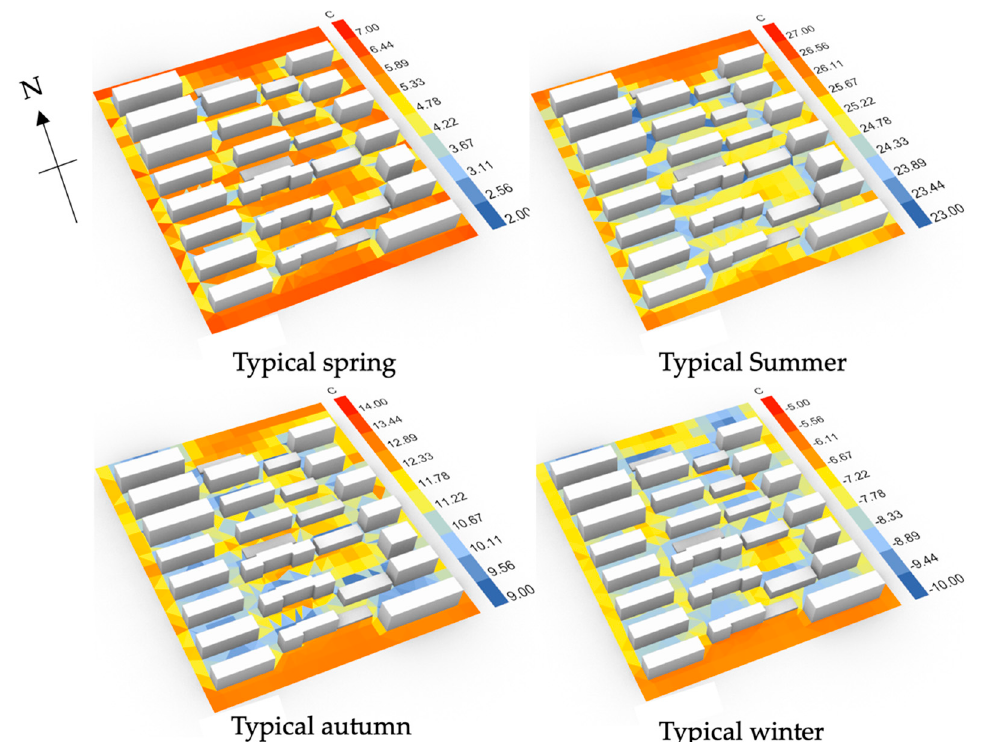
Figure 4. Digital simulation results of Nanshagou neighborhood.